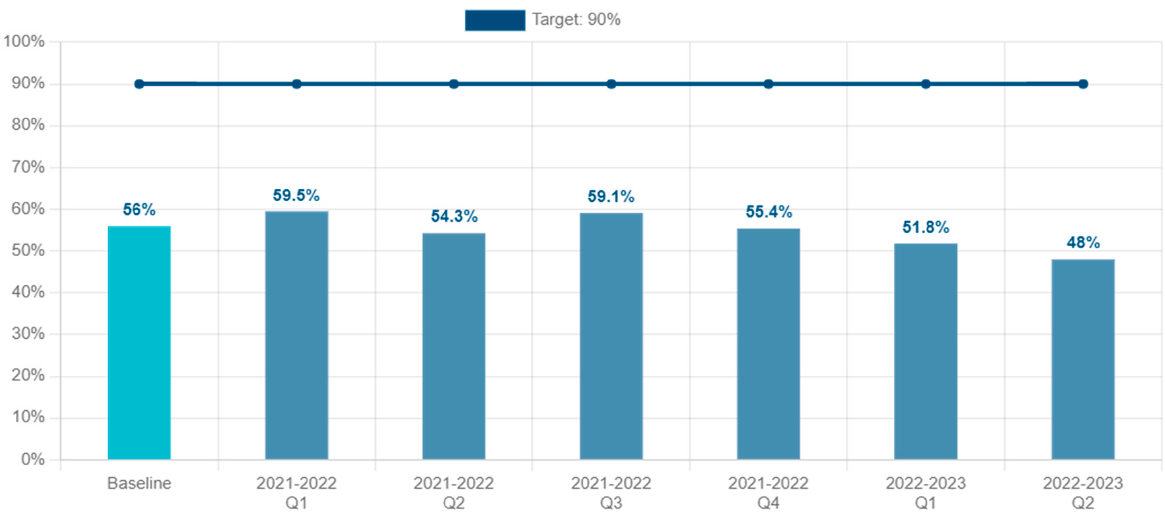
Figure 12. Percentage of non-endoscopic surgical services completed or wait times within benchmark [84].